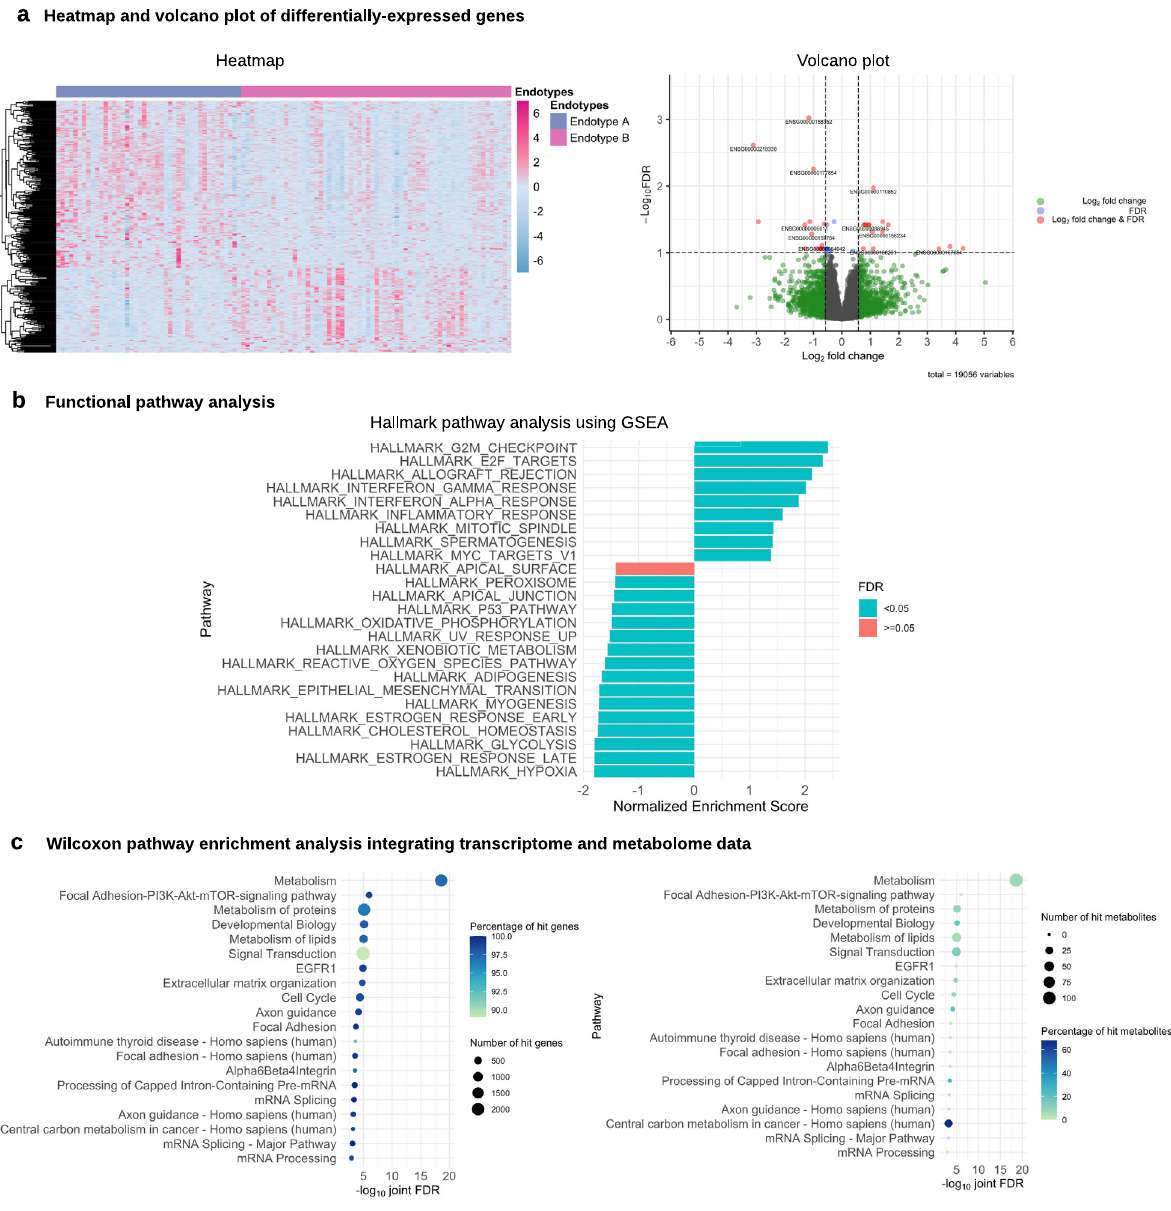
Fig. 5 Differential gene expression analysis and functional pathway analysis in the endotypes A vs. B comparison. a Heatmap and volcano plot of differentially expressed genes. For the heatmap (left), we selected 300 genes with the most signi fi cant P value (two-sided raw P value) and the color bar indicates the scaled value of variance stabilizing transformation. For the volcano plot (right), the threshold of log 2 fold change is |0.58| (i.e., ≥ |1.5|-fold change) and that of FDR<0.1. There were 29 differentially expressed genes that met these criteria. Of these, 11 Ensemble gene ids are annotated in the volcano plot due to space availability. These genes are presented in Supplementary Table 4. b Functional pathway analysis. For the functional class scoring analysis (left), we selected 25 pathways with the highest absolute value of normalized enriched score to visualize the plot. c Wilcoxon pathway enrichment analysis integrating transcriptome and metabolome data. For the Wilcoxon pathway enrichment analysis, we selected 20 pathways with the most signi fi cant joint FDR, and showed the numbers and proportions of hit genes (left) and metabolites (right) for the corresponding pathways. GSEA gene set enrichment analysis, FDR false discovery